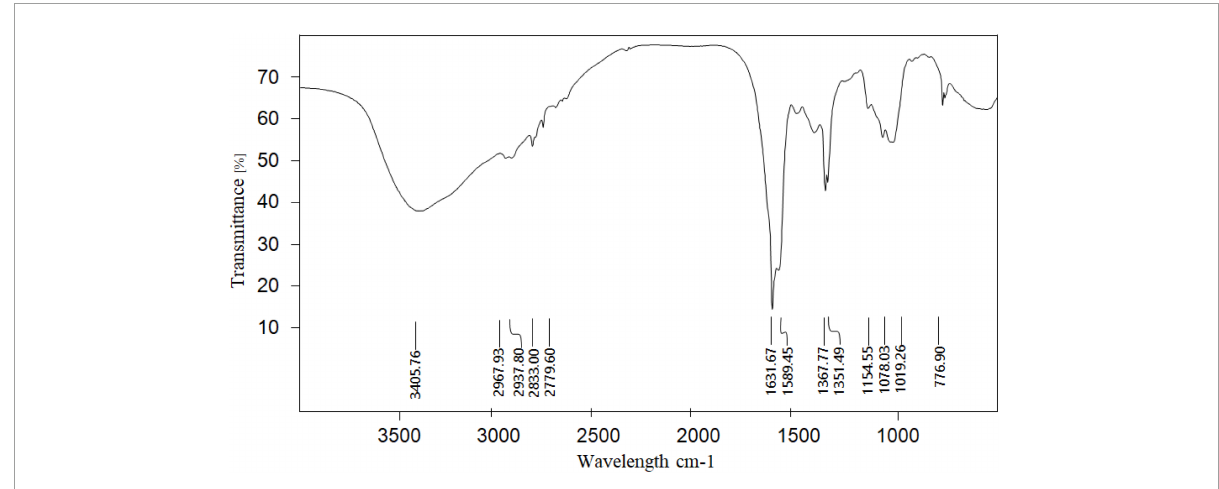
FIGURE4 Fourier infrared spectrum of Sparassis latifolia neutral polysaccharides SLNP.